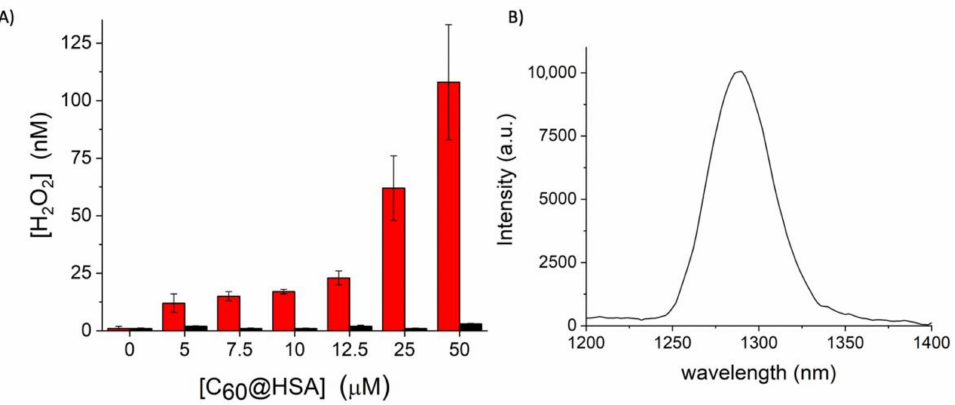
Figure 2. ( A ) Generation of peroxides during visible light irradiation (red histograms) and in the dark (black histograms) using different concentrations of C 60 @HSA. ( B ) Emission spectra of singlet oxygen generated upon the excitation of C 60